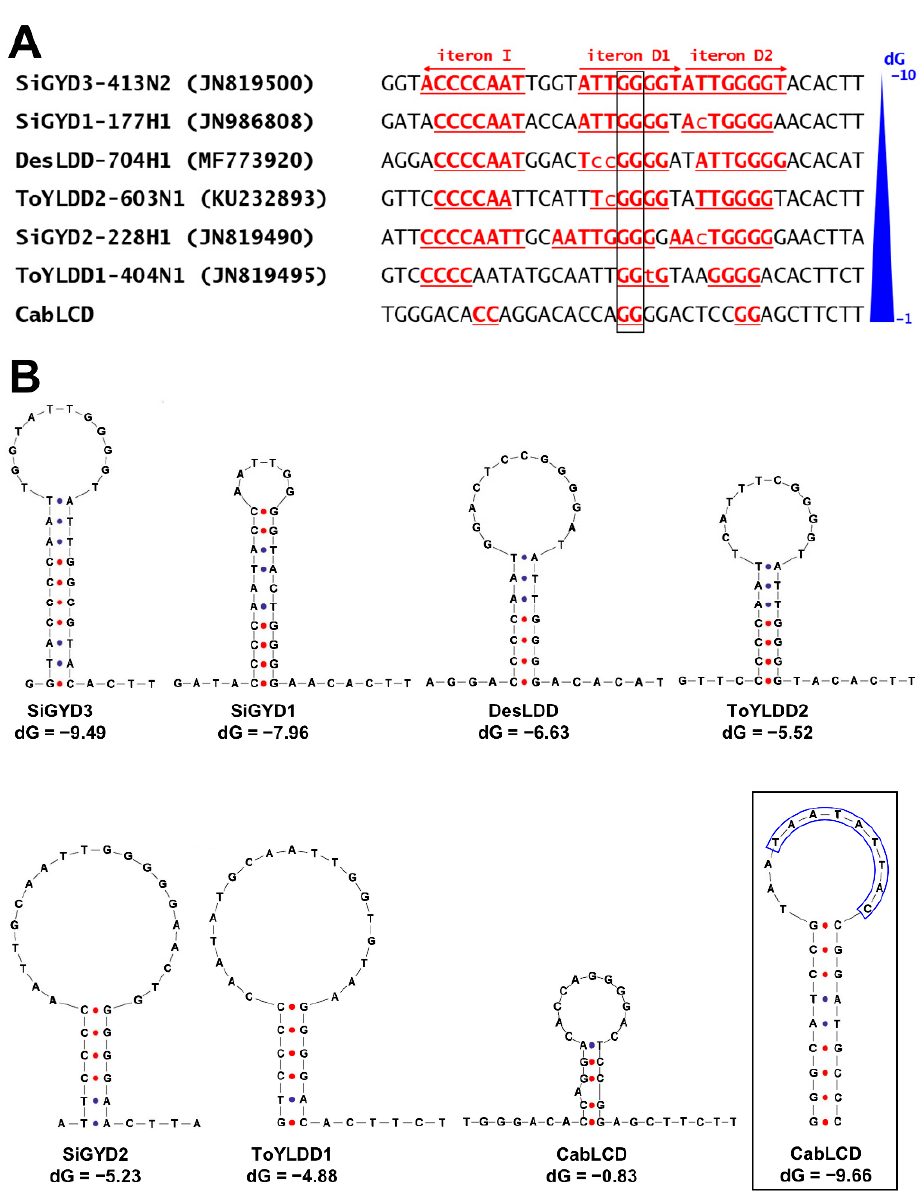
Figure 5. In silico analysis of the secondary stem-loop structure present in deltasatellites. ( A ) Alignment of the iteron-like sequences of the deltasatellite characterized in this work (cabbage leaf curl deltasatellite, CabLCD) and other New World deltasatellites (Sida golden yellow deltasatellite 3, SiGYD3; Sida golden yellow deltasatellite 1, SiGYD1; Desmodium leaf distortion deltasatellite, DesLDD; tomato yellow leaf distortion deltasatellite 2, ToYLDD2; Sida golden yellow deltasatellite 2, SiGYD2; tomato yellow leaf distortion deltasatellite 1, ToYLDD1). Direct (D1 and D2) and inverse (I) iterons are underlined and in red. Non-conserved nucleotides present in imperfect iterons are in lower case. The conserved GG motif in iteron D1 is boxed. Deltasatellites are ordered from lower to higher Gibbs free energy (dG) of the predicted secondary structure for the genomic region shown. ( B ) Secondary structures for the putative secondary stem-loop structure present in CabLCD and the other deltasatellites included in panel A predicted by free energy minimization. The CabLCD stem-loop containing the conserved nonanucleotide TAATATTAC (boxed and in blue) is included for comparison.